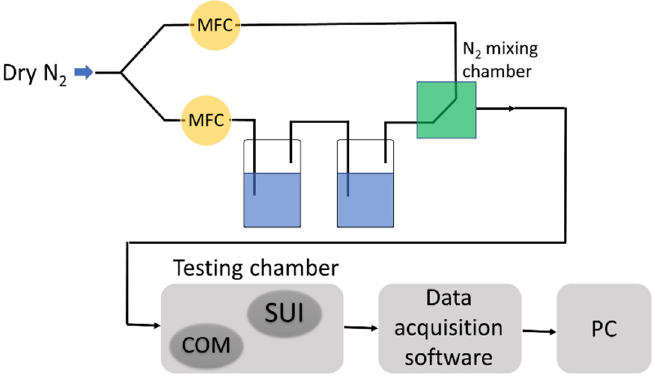
Figure 5. Experimental setup employed for RH measurements (MFC—mass flow controller, SUI – sensor under investigation, COM—commercial sensor)